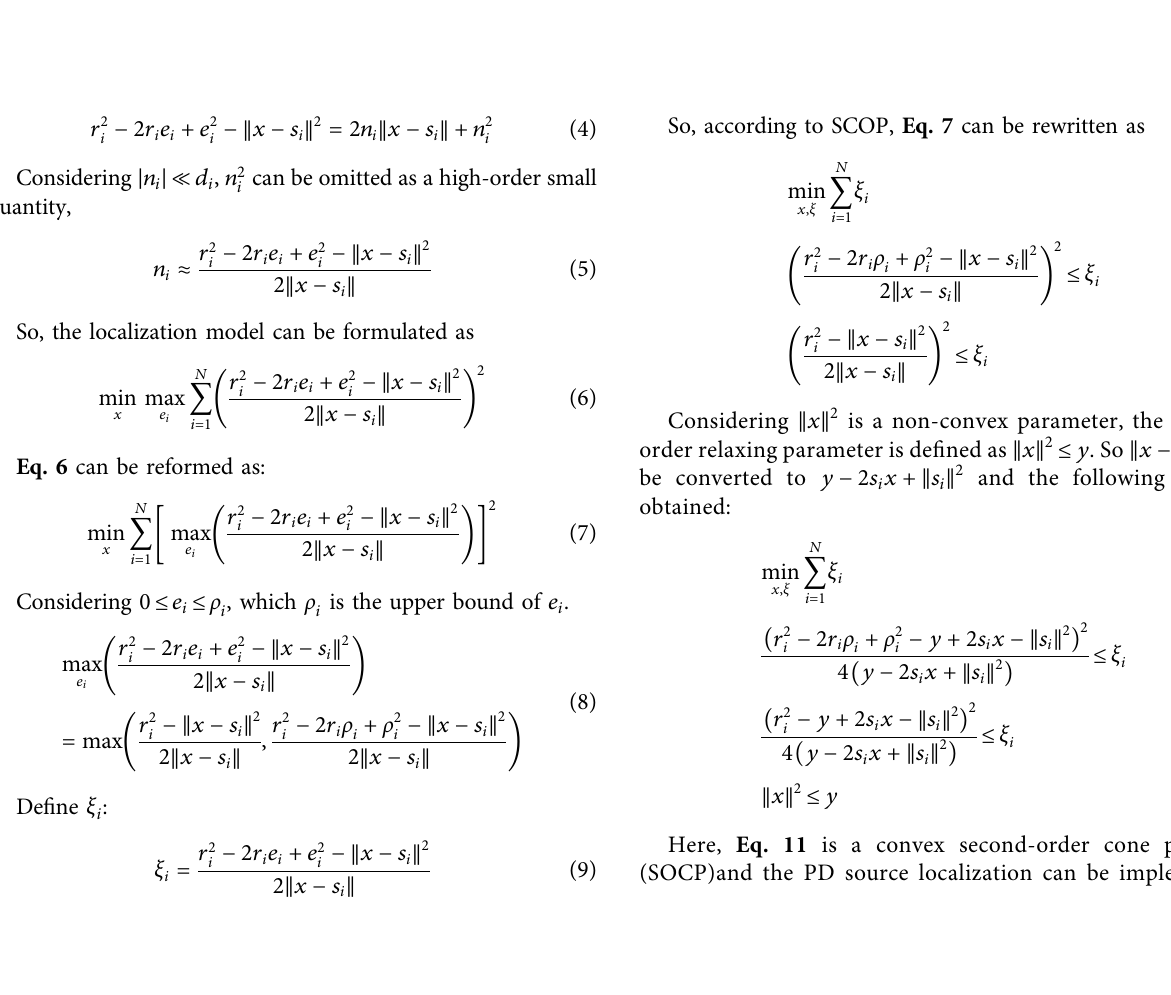
Frontiers in Energy Research |